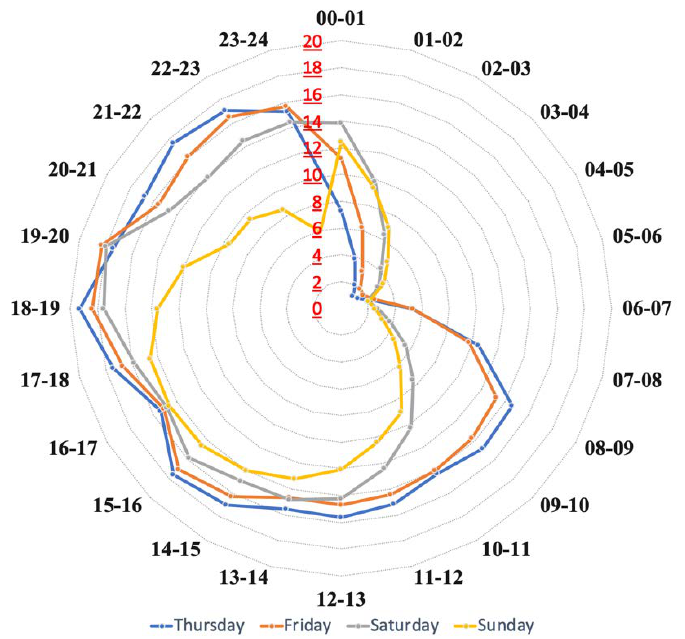
Figure 7. Hourly energy consumption for Thursday (6 December), Friday (7 December), Saturday (8 December), Sunday (9 December) in the radar representation graph with the scale of a megawatt-hour (MWh).